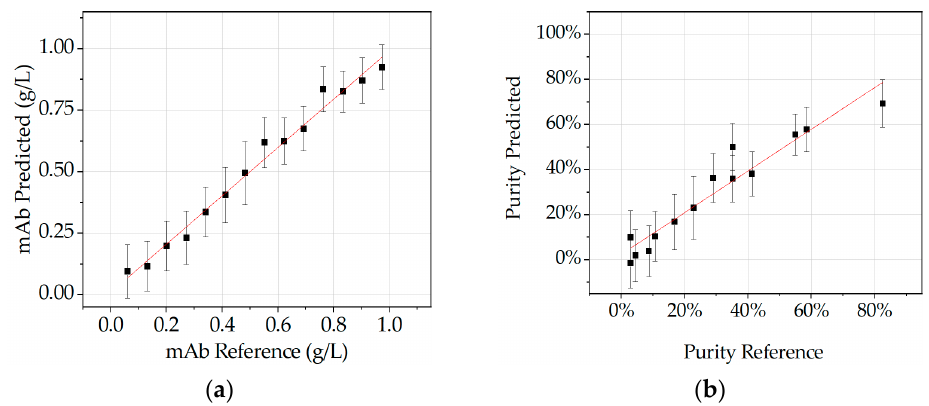
Figure 17. Prediction of process data using combination of DAD and Raman. IgG concentration ( a ), purity of the target component ( b ).